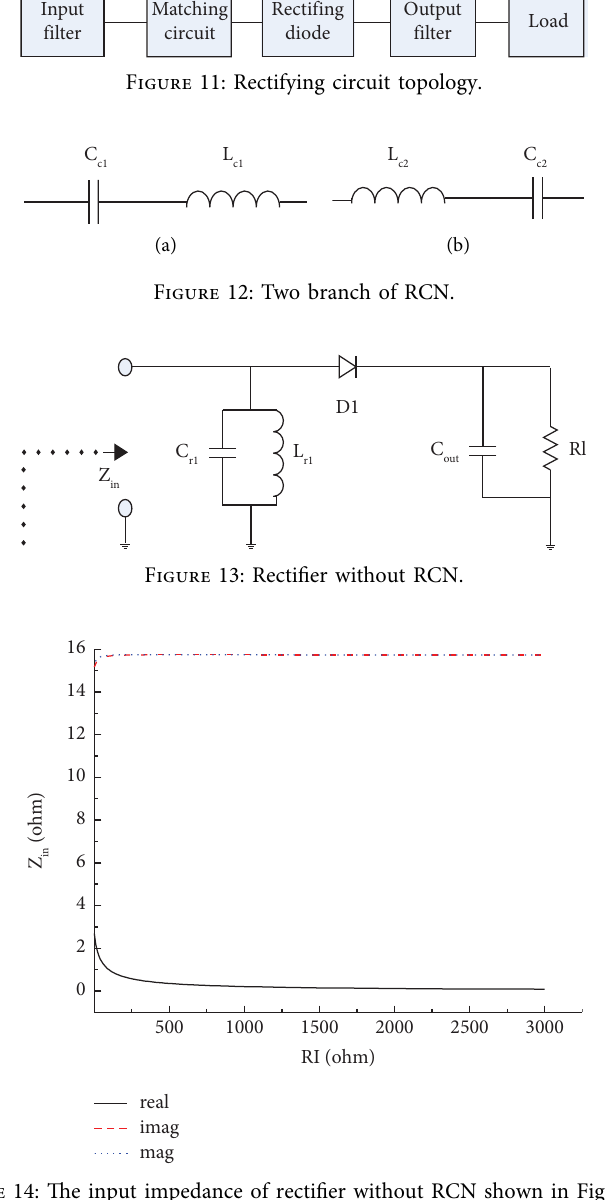
Figure 14: Te input impedance of rectifer without RCN shown in Figure